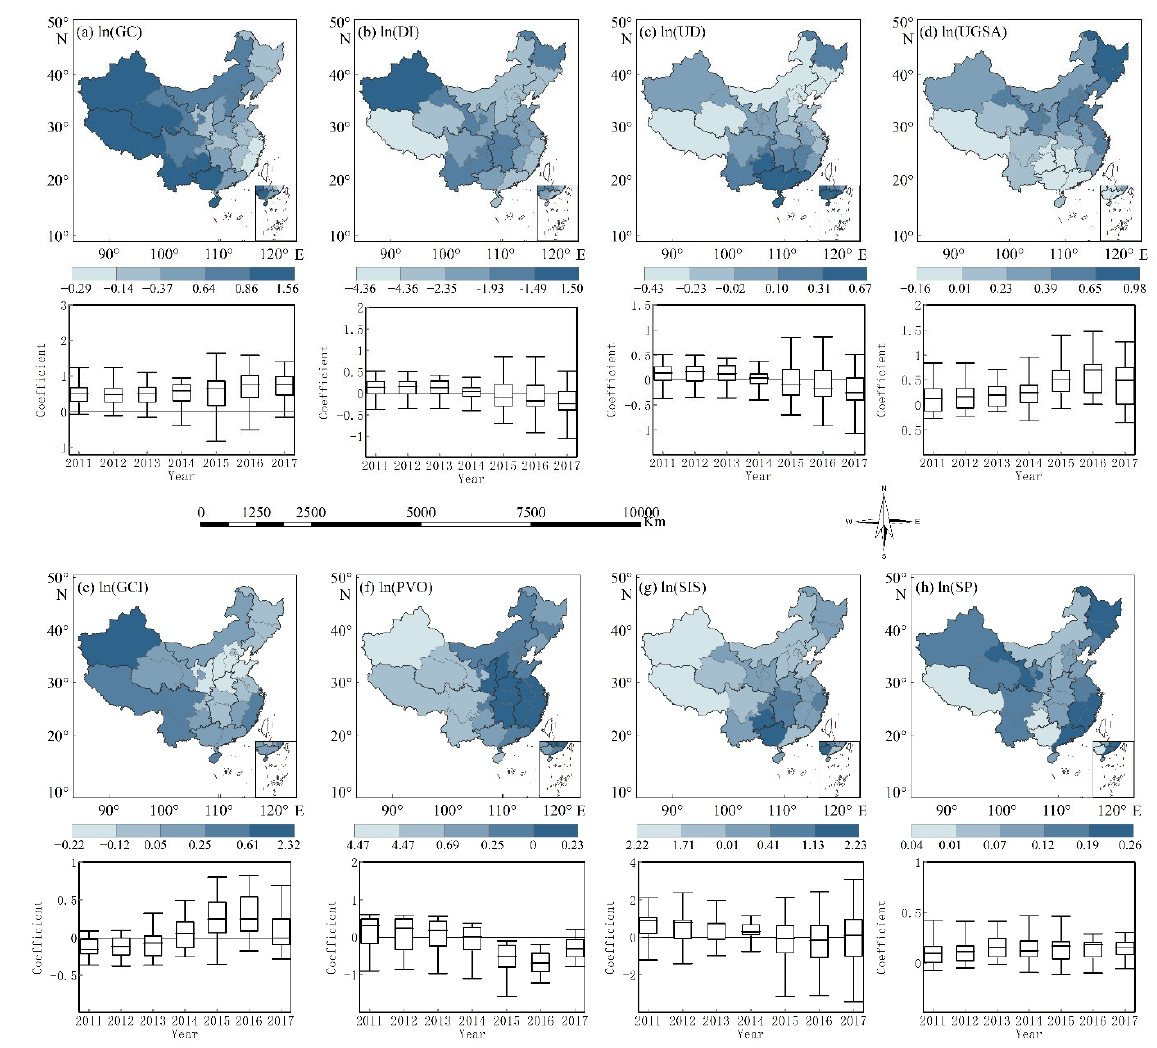
Figure 7. Spatial distribution and temporal variations in various coefficients of SO 2 in the geographically and temporally weighted regression (GTWR) model.